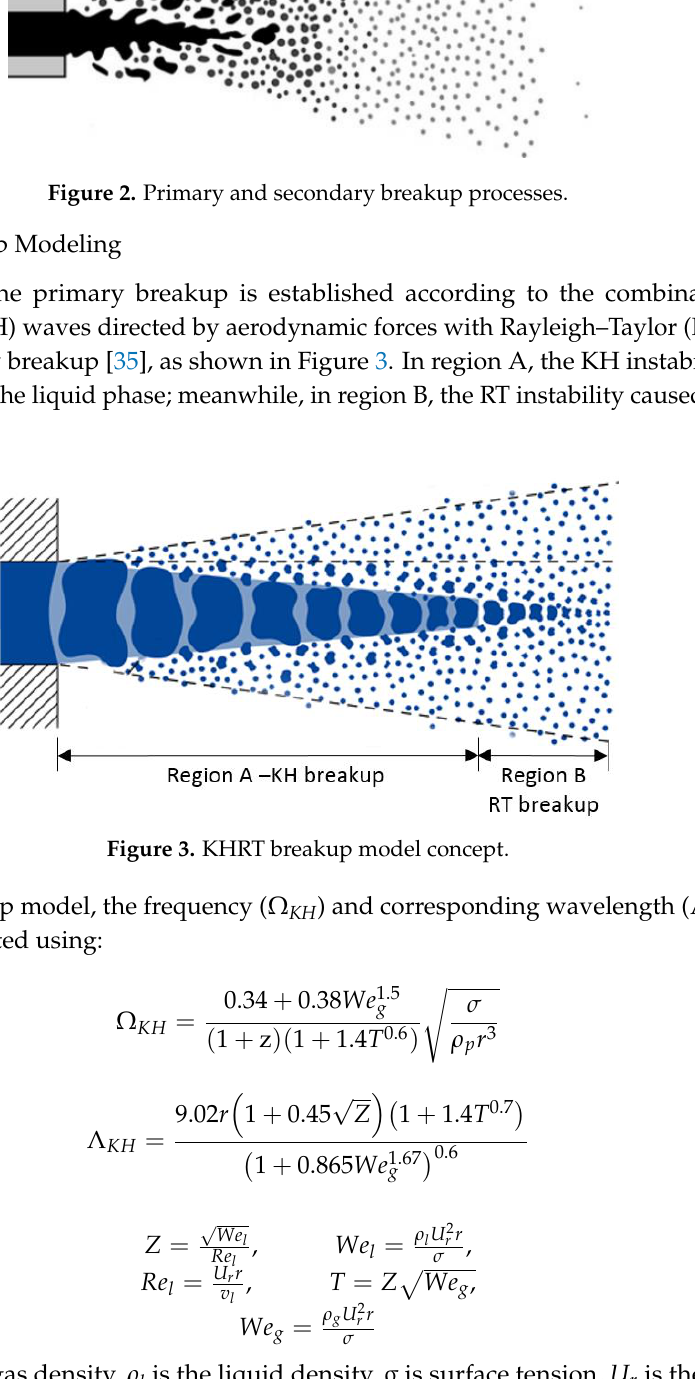
Figure 2. Primary and secondary breakup processes.